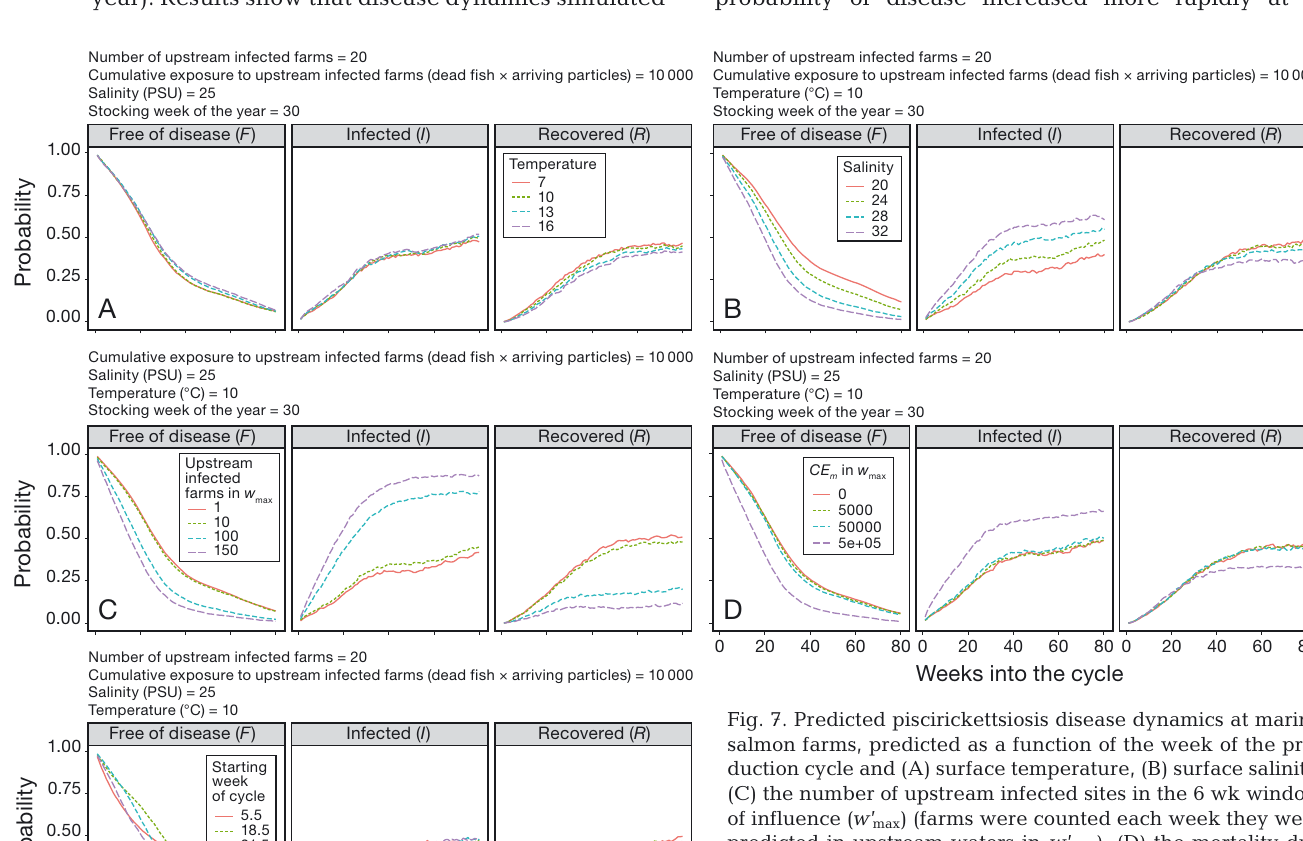
Fig. 7. Predicted piscirickettsiosis disease dynamics at marine salmon farms, predicted as a function of the week of the pro- duction cycle and (A) surface temperature, (B) surface salinity, (C) the number of upstream infected sites in the 6 wk window of influence (w ’ max ) (farms were counted each week they were predicted in upstream waters in w ’ max ), (D) the mortality due to piscirickettsiosis in upstream farms corrected by the strength of farm-to-farm hydrodynamic connections (CE m ) , and (E) the week of the year at which the farm was stocked with salmon smolts, specifically mid-fall (Week 5.5 of the